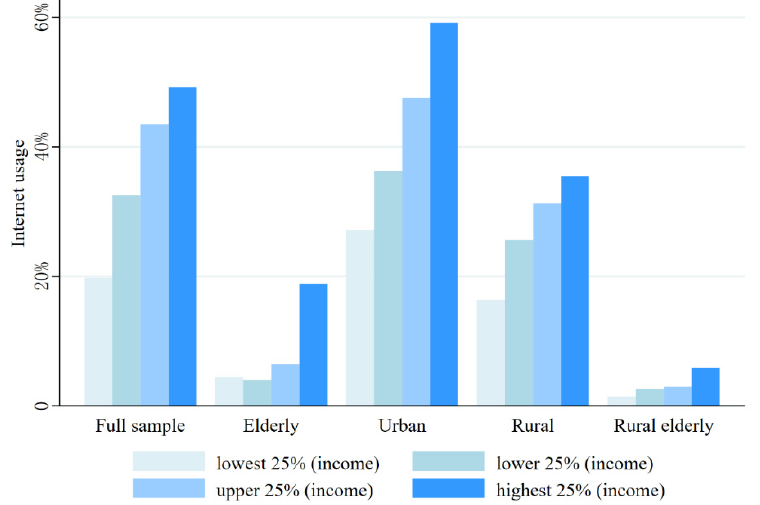
Figure 3. Internet usage by different groups.